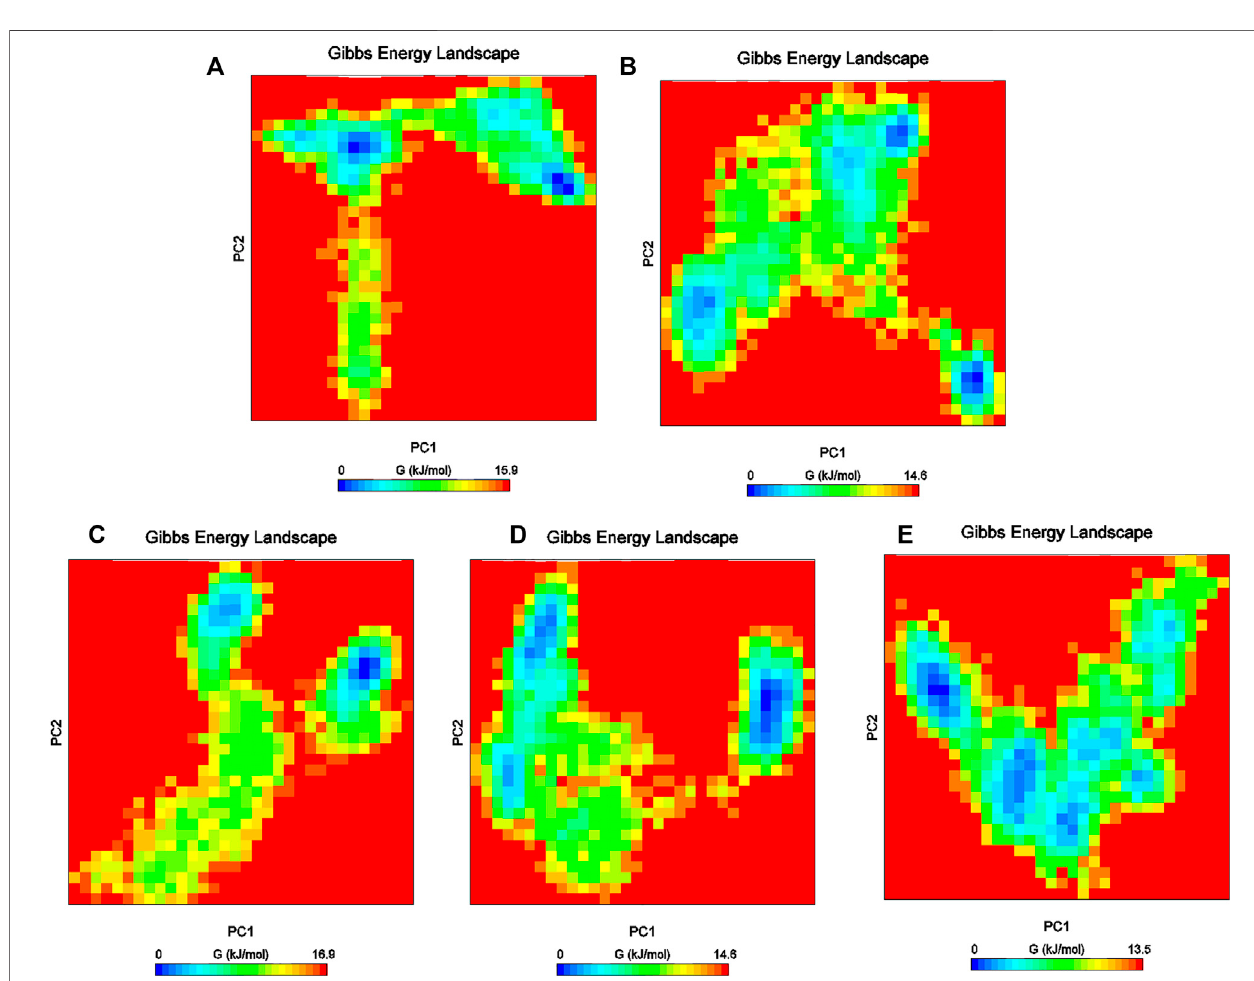
Frontiers in Molecular Biosciences |